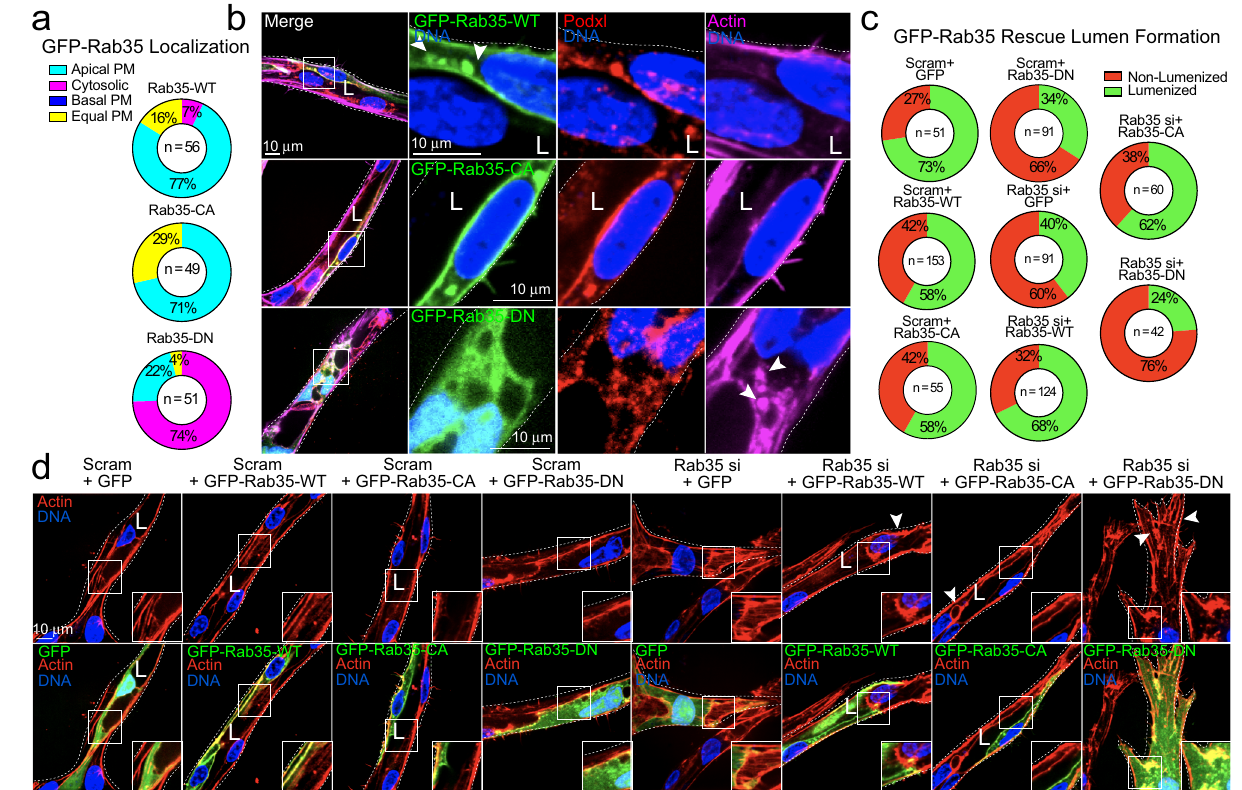
Fig. 2 | Rab35 mutant localization and rescue in endothelial sprouts. a Quanti fi cation of GFP-Rab35 wild-type (WT), constitutively-active (CA), and dominant-negative (DN) localization in endothelial sprouts. Apical plasma mem- brane (PM, uniformly localized to apical membrane), basal PM (Rab35 uniformly located at the basal membrane), cytosolic (localized in the cytoplasm), equal PM (Rab35 equally distributed between the apical and basal membranes). n = number ofcells. b GFP-Rab35WT(toppanels),CA(middlepanels),andDN(bottompanels) localization in endothelialsprouts. Co-staining with podocalyxin(Podxl) and actin. ArrowheadsintoppanelsdenoteRab35apicallocalizationandpuncta.Arrowheads